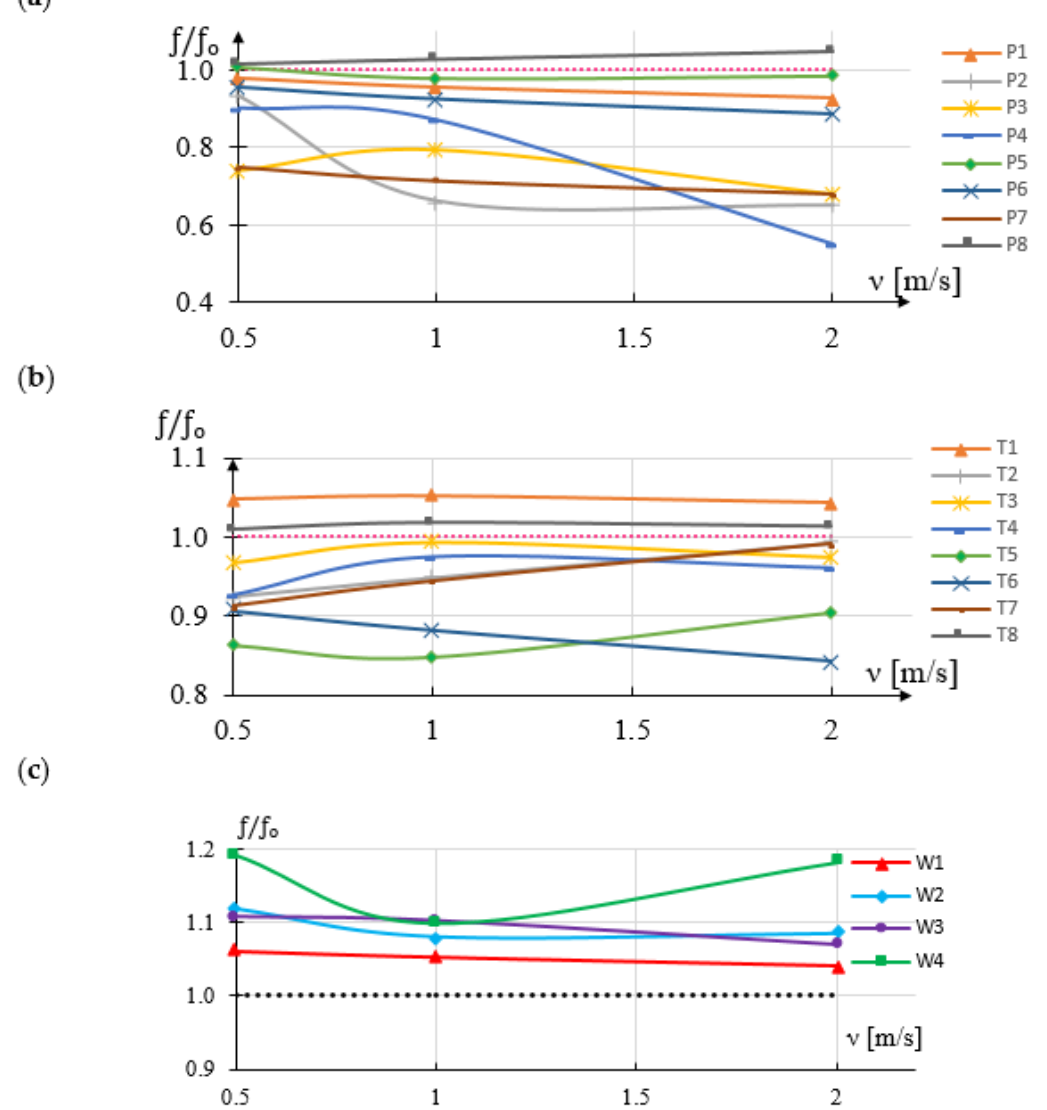
Figure 6. Shapes resulting from ( a ) rake surface modification ( b ) runoff surface modification ( c ) oval. The more the f/f 0 ratio differs from 1, the greater the impact on the sensitivity of the flowmeter will be the modification of the surface areas consistent with the markings in Figure 6. As it results from Figure 6a, the greatest impact on the sensitivity of the vortex flowmeter is the modification of areas 1 and 3 together with areas 2 and 4. In this type, the greatest variations are obtained for different flow velocity, but the variations are non-lin- ear. Modifying only areas 3 and 4 or 1 and 2 does not bring such good results. The modi- fications to the P3 and P4 deserve special attention here In the case of the runoff surface modification, a significant improvement in the flow- meter sensitivity is obtained for the shapes T2 and T7. These shapes have a sharp edge, which makes it easier to detach the vortices. Modification of the upper and lower flow surfaces of the vortex shedder bar (shapes in Figure 6c) mainly increases the frequency of the generated vortices, but does not signif- icantly affect the sensitivity of the flowmeter. Only the modification of W3 has a visible effect on the sensitivity.